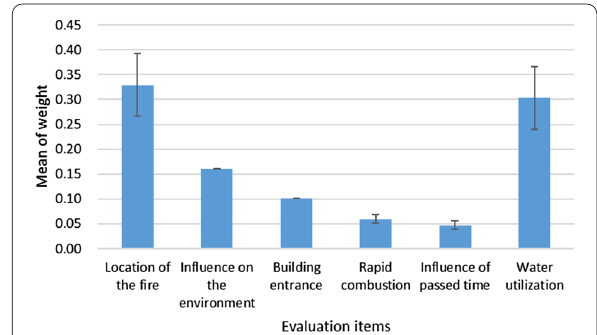
Table 3 Classification of the evaluation items for a